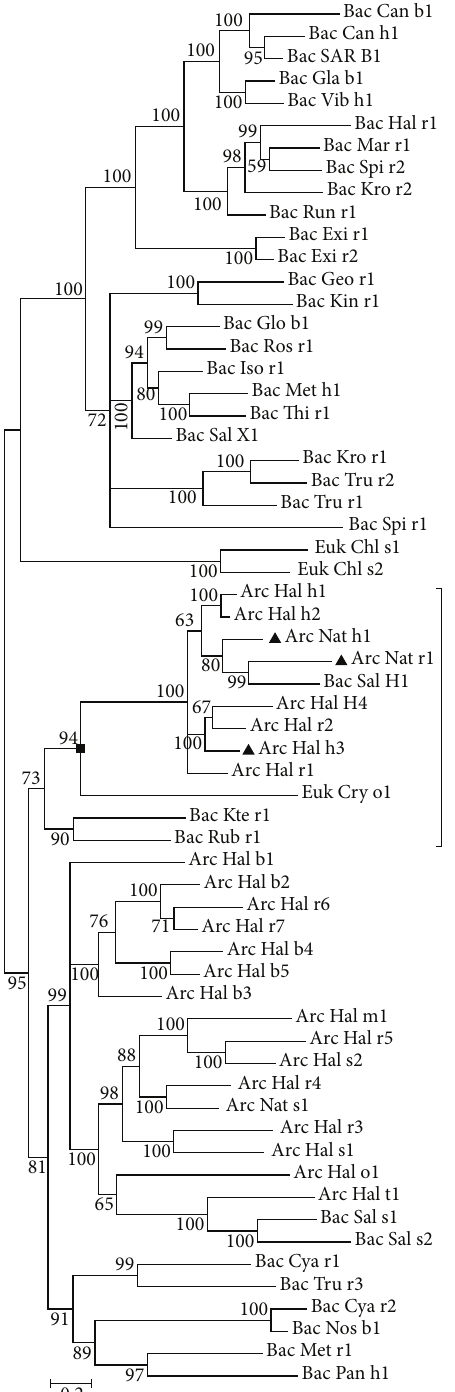
Figure 3: Unrooted Bayesian tree for all microbial rhodopsin genes. The numbers adjacent to the nodes are posterior probability values. The length of branch reflects evolutionary divergence. Microbial rhodopsin genes distantly related to metazoan rhodopsin’s ancestral states ( > 95% quantile) are marked with a filled black triangle (cid:3) . The tree node where microbial rhodopsin’s ancestral state is built on is markedwithafilledblacksquare (cid:2) .Inallpossibleancestralstateson that branch (marked with vertical line), this microbial rhodopsin’s ancestral state has the smallest mutation distance with metazoan rhodopsin’s ancestral